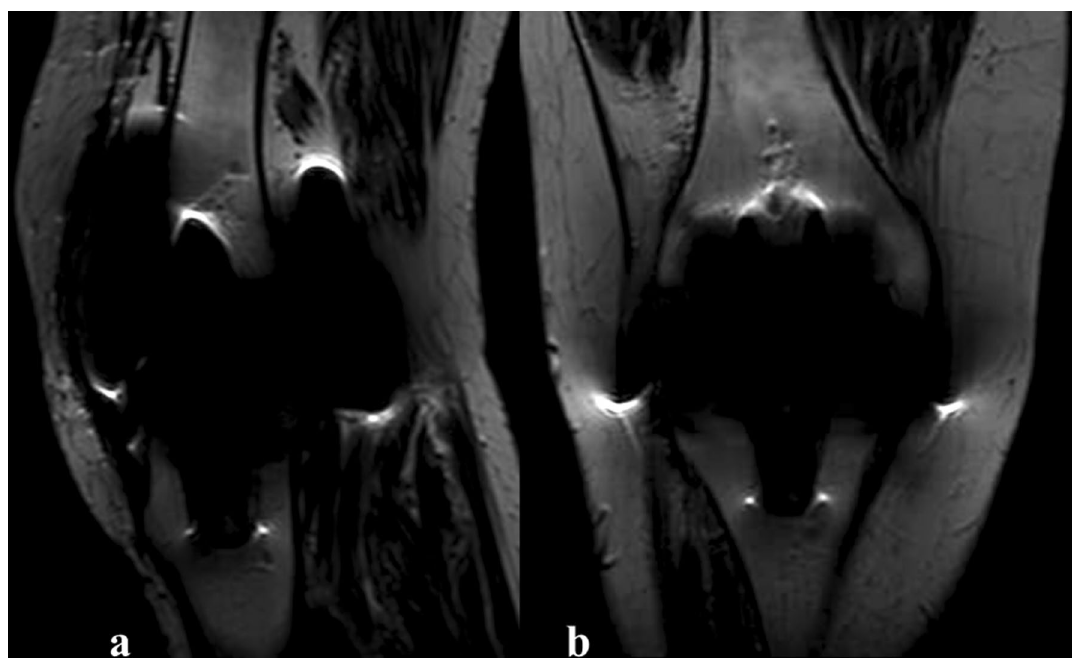
Figure 2. T1-weighted ( a ) sagittal and ( b ) coronal MRI images showing severe metallic